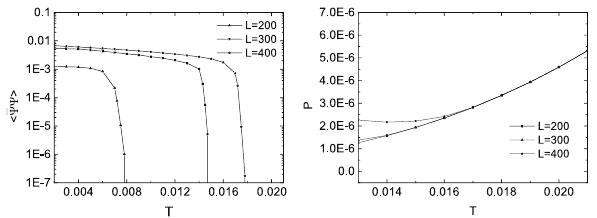
Fig. 4 The dependence of the fermion chiral condensate (left) and pressure (right) on the temperature with several volume